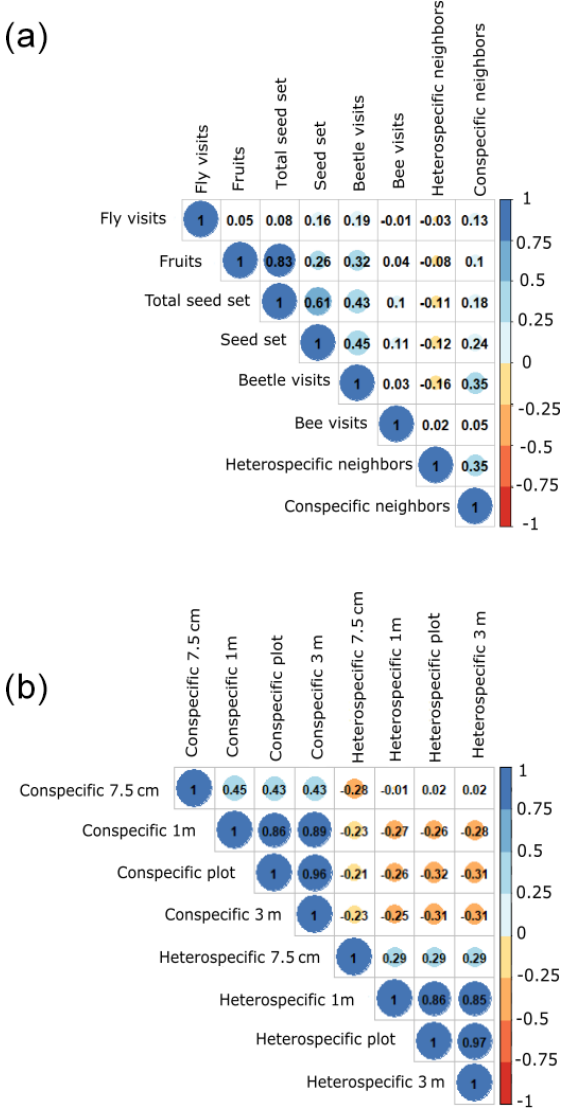
Figure A4. These plots show the correlations between the different variables. Panel (a) shows the correlations between all the variables included in the model per the three species. The total seed set data shown are per plant individual. Panel (b) shows the correlations be- tween the different scales of neighbors (7.5cm radius and 1, 9 and 36m 2 , plot level). The dark colors of the cells indicate that there is a strong correlation, and the light colors mean the opposite – there is a slight